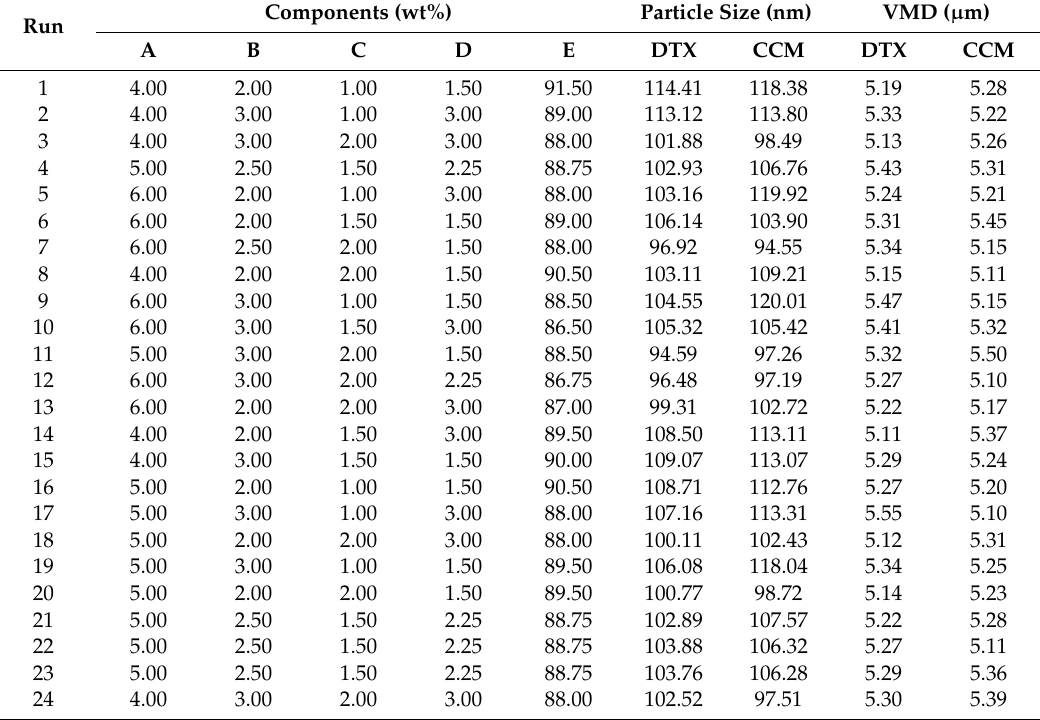
Table 1. Candidate points of D-optimal mixture experimental design together with the obtained particle size and aerosol size (VMD) of the docetaxel (DTX)- and curcumin (CCM)-loaded